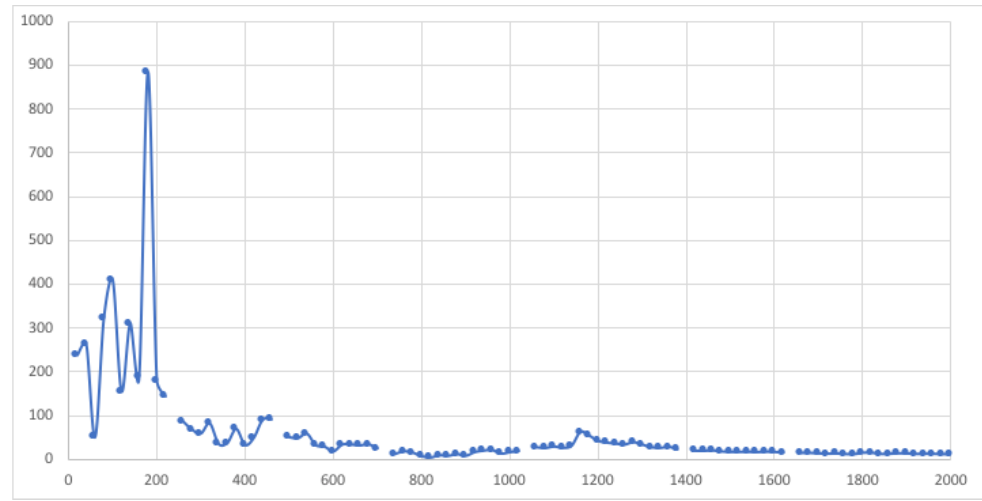
Figure A3. A single scan enlarged, a fast scan. See text for discussion.